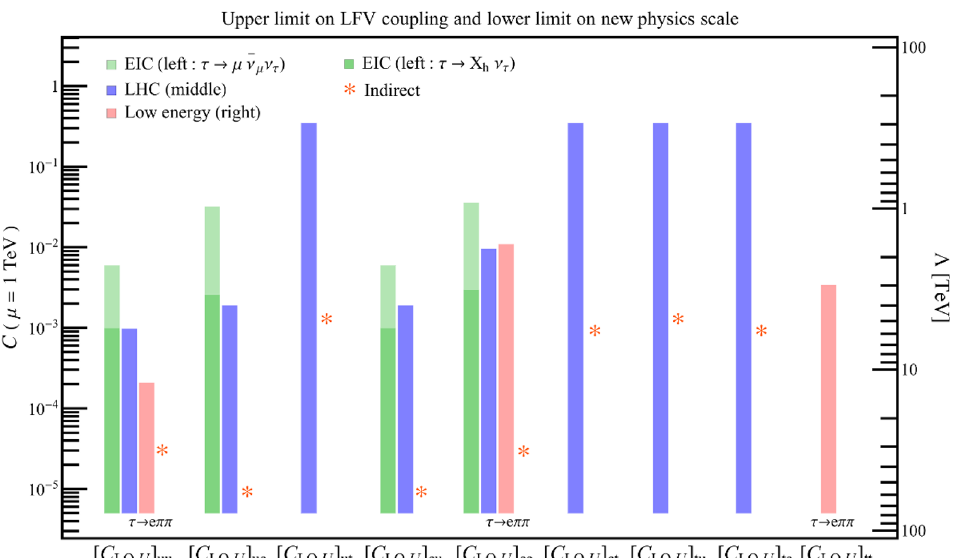
Figure 16 . Upper limit on C LQ,U (leftmost axis) and lower limit on new physics scale Λ (rightmost axis). For the EIC expected sensitivity, the light green bar corresponds to the result in table 7, while the dark green one represents the case in hadronic tau decay mode assuming (cid:15) n b = 0 in tables